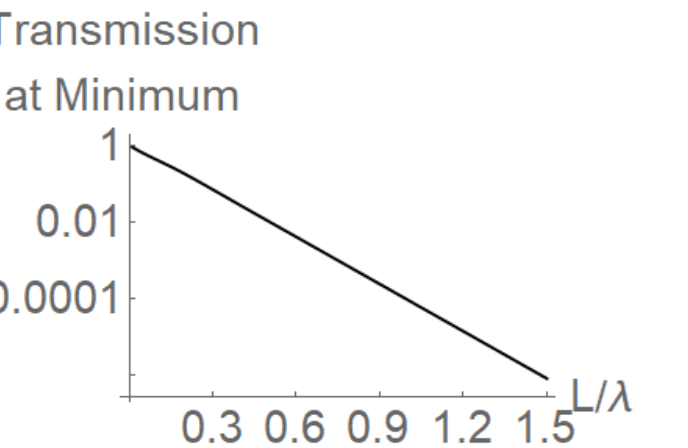
Figure 3. We plot the values of the transmission coefficient at the different values of Ω shift corre- sponding to the different lengths of the cloud.